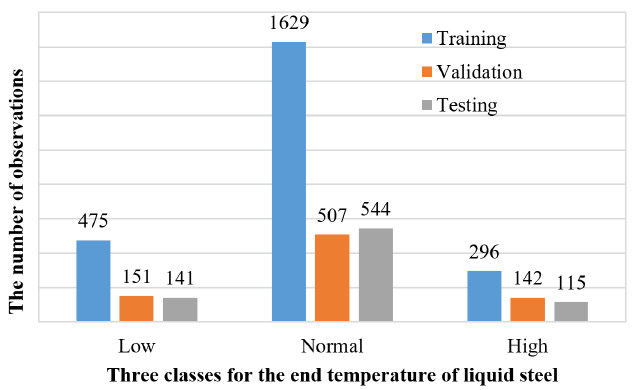
Figure 3. Distribution of the temperature points in terms of low, normal, and high. The numbers on the top of each column denote the values of the ordinates, for example 475 indicates that there are 475 points that fall into the low temperature range for the training data set. The meaning of the other numbers is analogous.